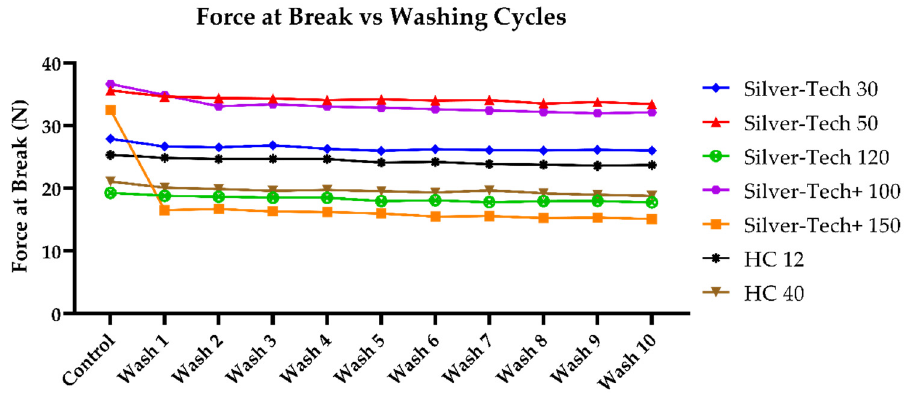
Figure 7. Change in force at break after washing across all tested thread samples without protective polyamide thread on top.